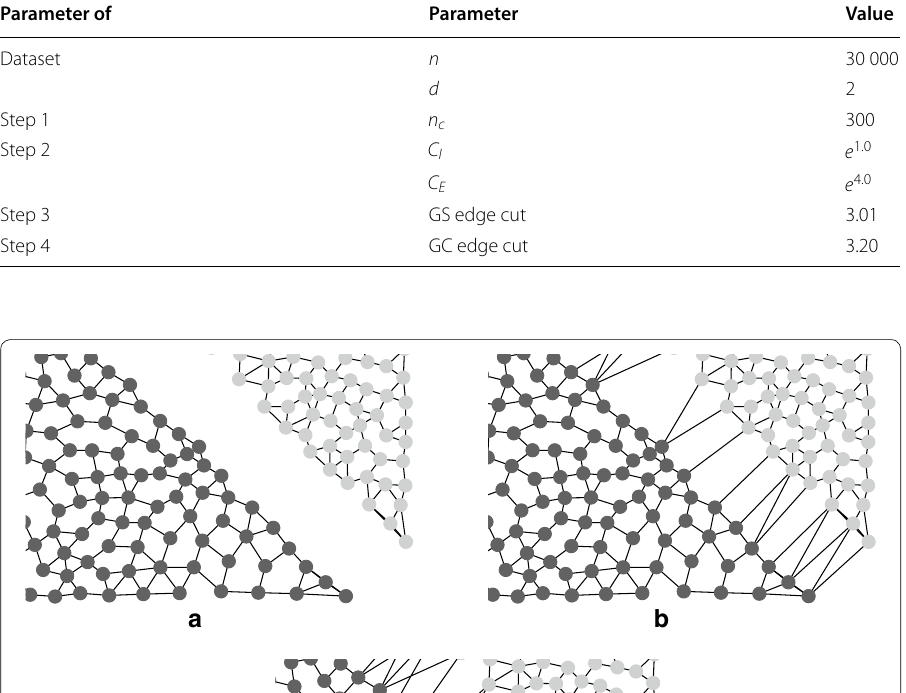
Table 1 Dataset along with steps parameters Parameter of